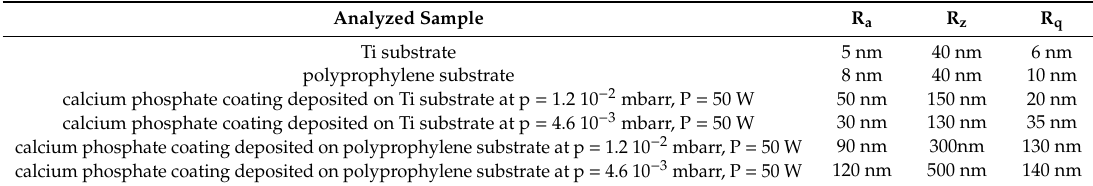
Table 2. Roughness measurements of the substrates and CaP coatings. Analyzed